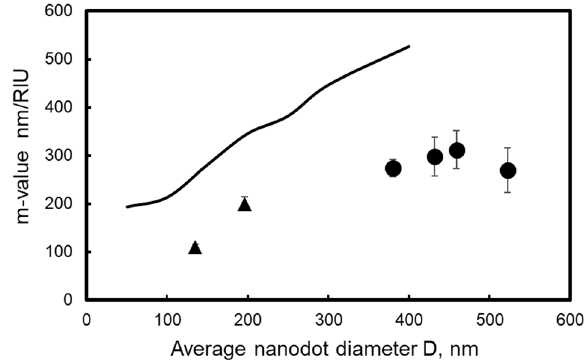
Figure 14. Change in sensitivity against average dot diameter. ● : data obtained from Figure 13, ▲ : data referred from a previous report [35], curve: calculated date.